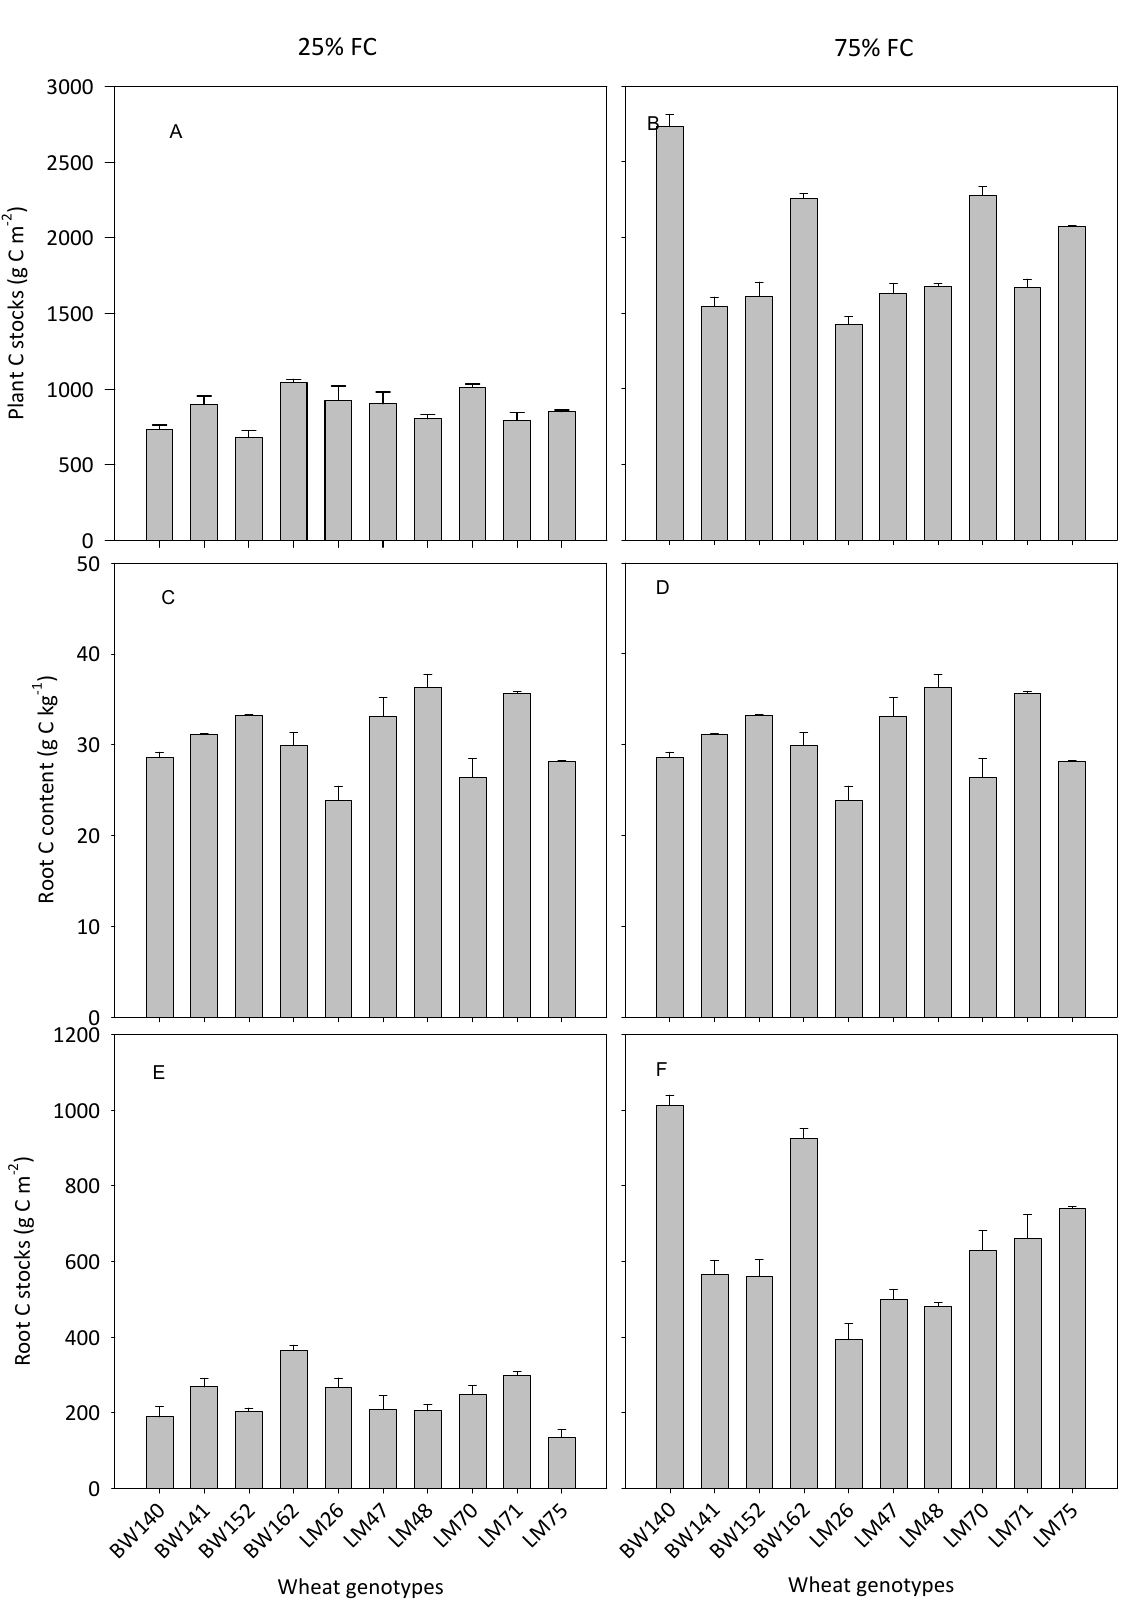
Figure 5. Variation in plant C stocks ( A , B ), root C content ( C , D ) and root C stocks ( E , F ) due to genotype and soil water availability (25 and 75% field capacity) under greenhouse conditions. Data are mean and standard errors (n = 9).